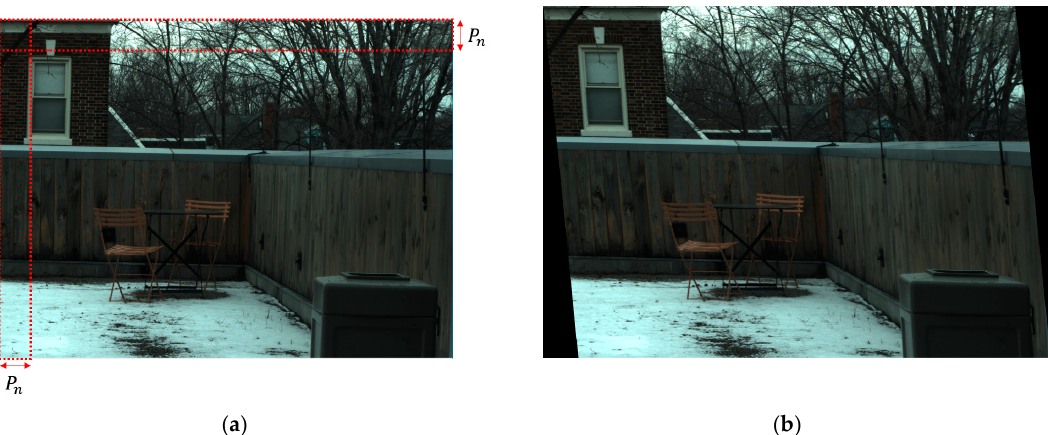
Figure 5. Example of pixel mismatch representation using ( a ) cutting off ( 𝑃 (cid:3041) indicates the number of pixels cut off from the left and upper sides) and ( b) shear transformation.